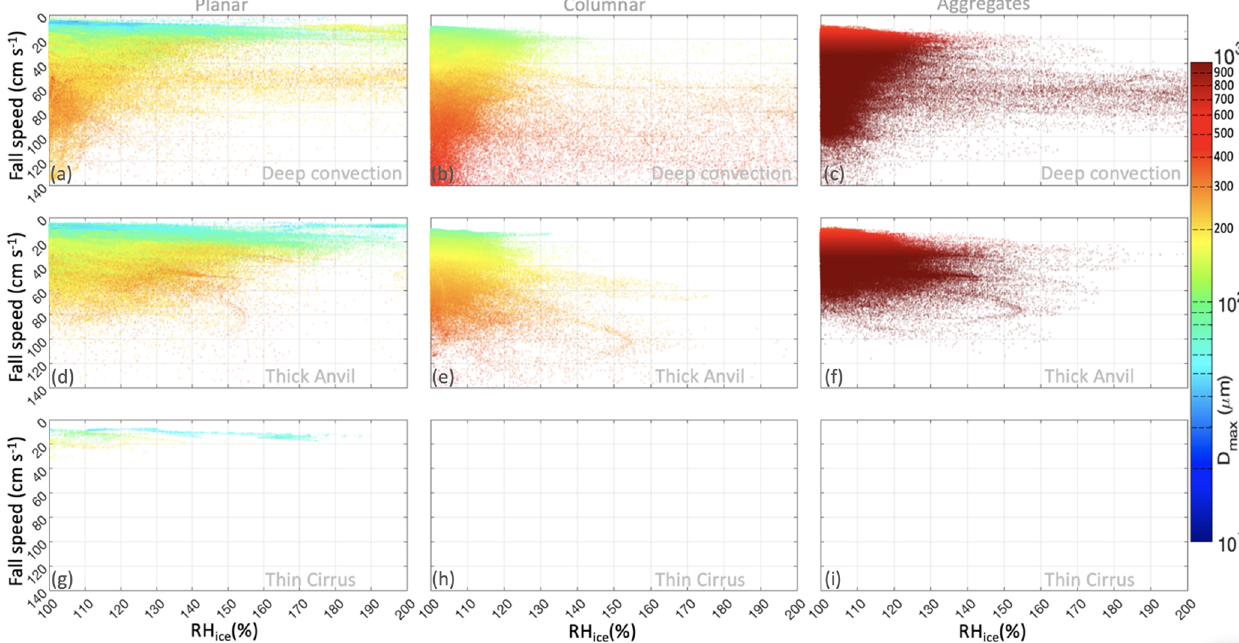
Figure 16. Scatter plots of ice particle fall speed as a function of relative humidity with respect to ice (RHi), color coded by maximum dimension ( D max ) for three different ice habits, i.e., planar (a, d, g) , columnar (b, e, h) , and aggregate (c, f, i) , and three different regions,